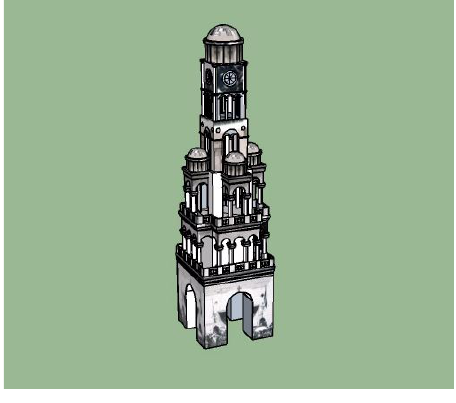
Figure – 9 Digital Reconstruction St Photini Church